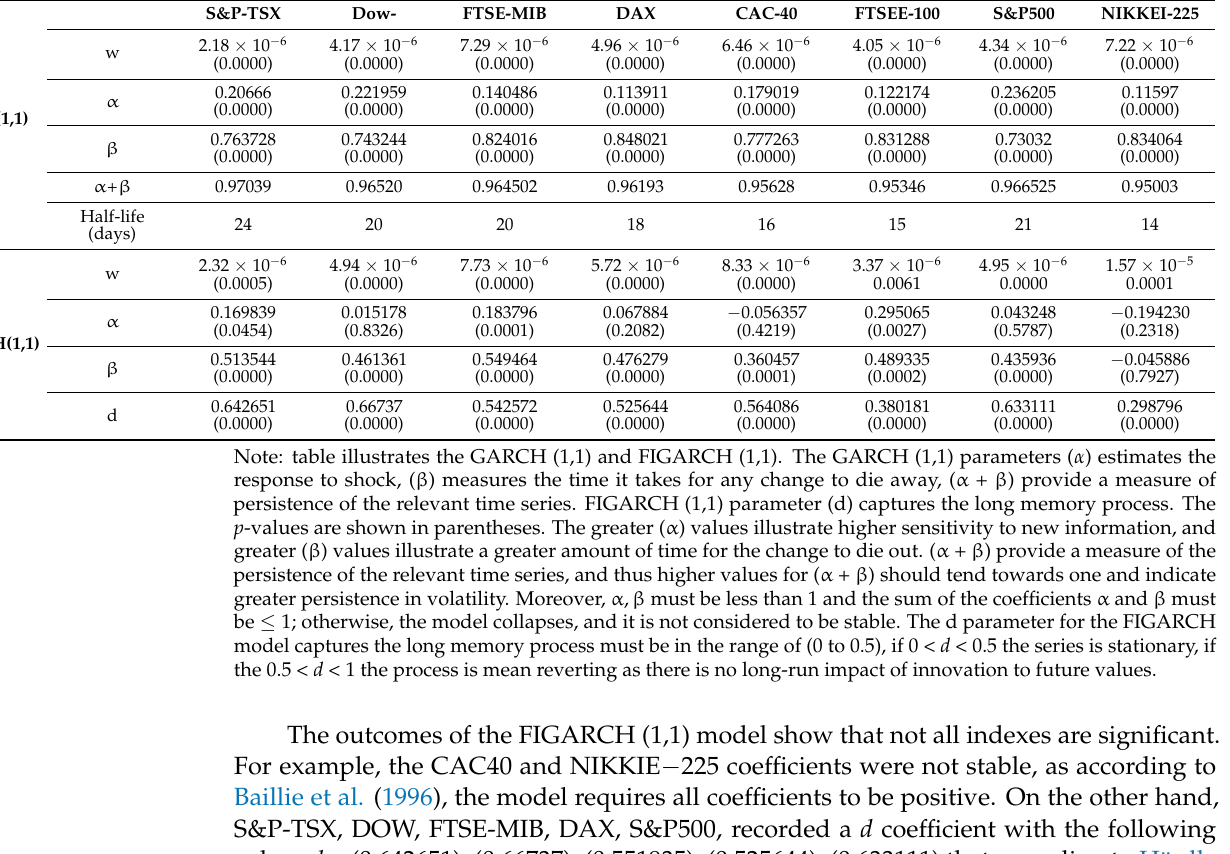
Figure 5. G7 volatility clustering (sources Data Stream). The outcomes of the FIGARCH (1, 1) model show that not all indexes are significant. Table 9. G7 Volatility For example, the CAC40 and NIKKIE − 225 coefficients were not stable, as according to Baillie et al. (1996), the model requires all coefficients to be positive. On the other hand,